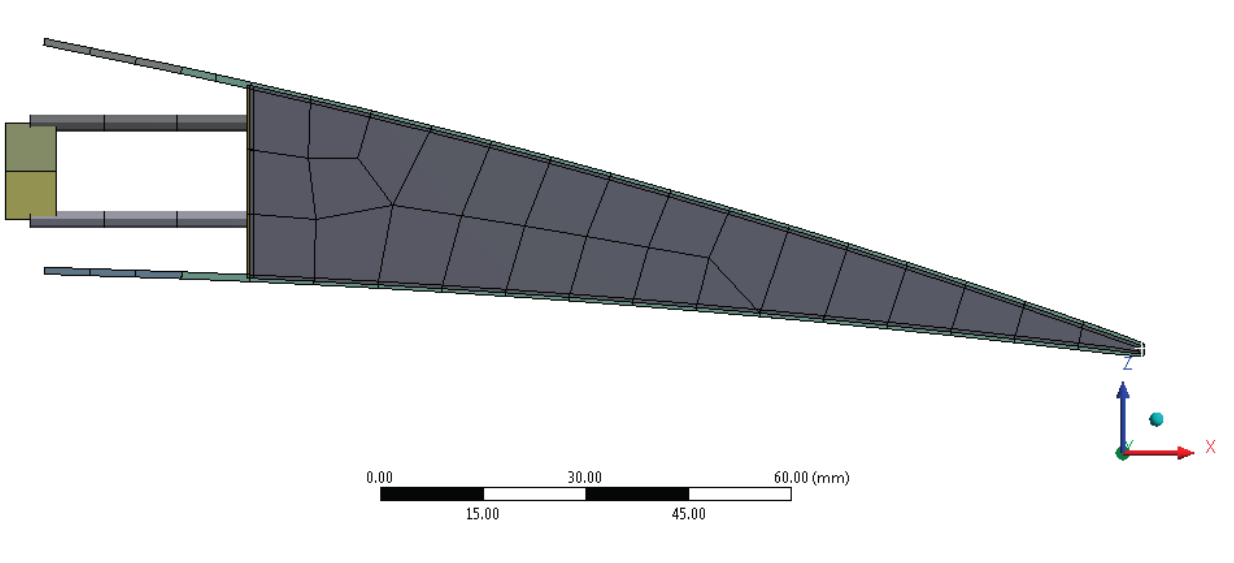
Figure 15. Isometric view of generated mesh for closed cell design.